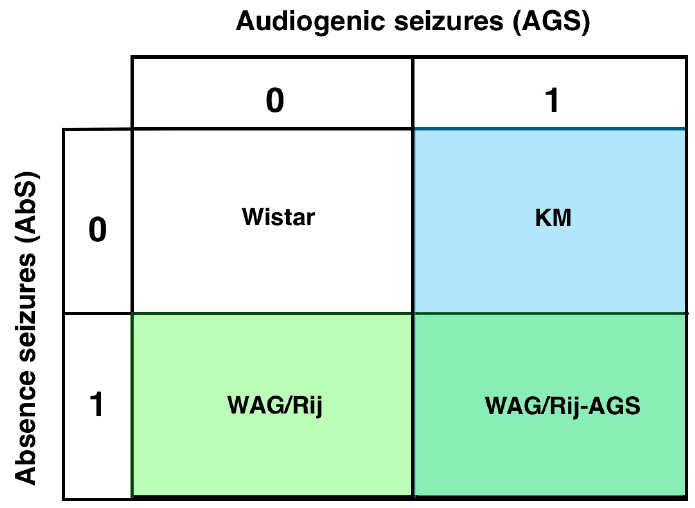
Figure 1. The experimental design: four groups are included in the comparison. WS controls (0-0), KM (only audiogenic seizures, 0-1), WAG/Rij (only absence seizures, 1-0) and rats with mixed types of generalized seizures (WAG/Rij-AGS, 1-1).